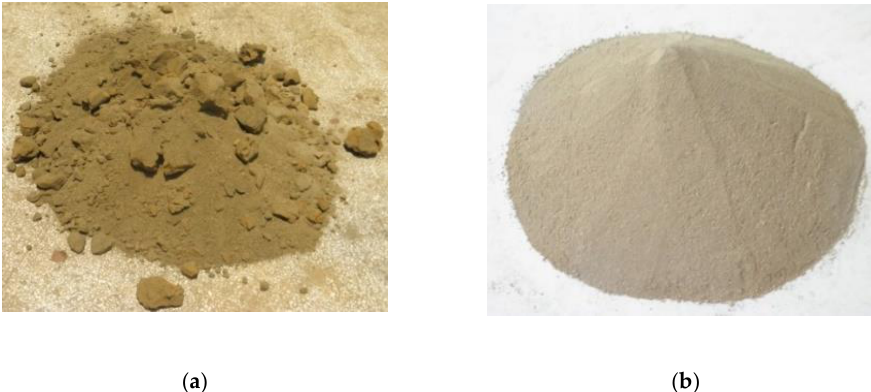
Figure 3. Tailings sample used in this study: ( a ) raw sample from the tailings pond; ( b ) sample after drying and crushing.